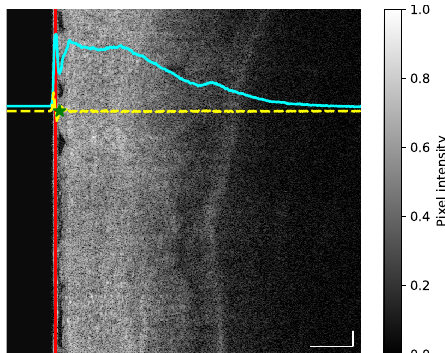
Figure 1. (Best viewed in color) Example of preprocessing applied to each volumetric laser endomicroscopy (VLE) frame. At the left side of the image the balloon line (red line) is located by calculating the average intensity of the whole image (cyan line) and then using the first derivative (yellow line) to extract the end point of the balloon pixel (green star). Scale bars: 0.5